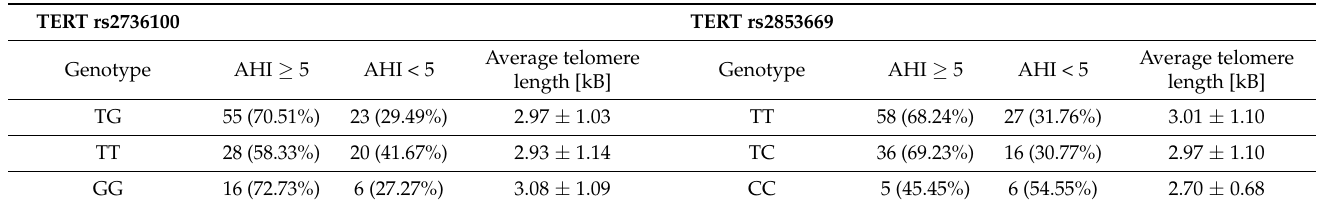
Table 3. The prevalence of the TERT SNP’s in patients with and without OSA. Statistically significant differences are indicated by boldface ( p < 0.05).